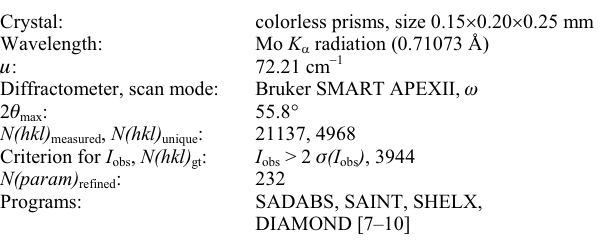
Table 1. Data collection and handling.